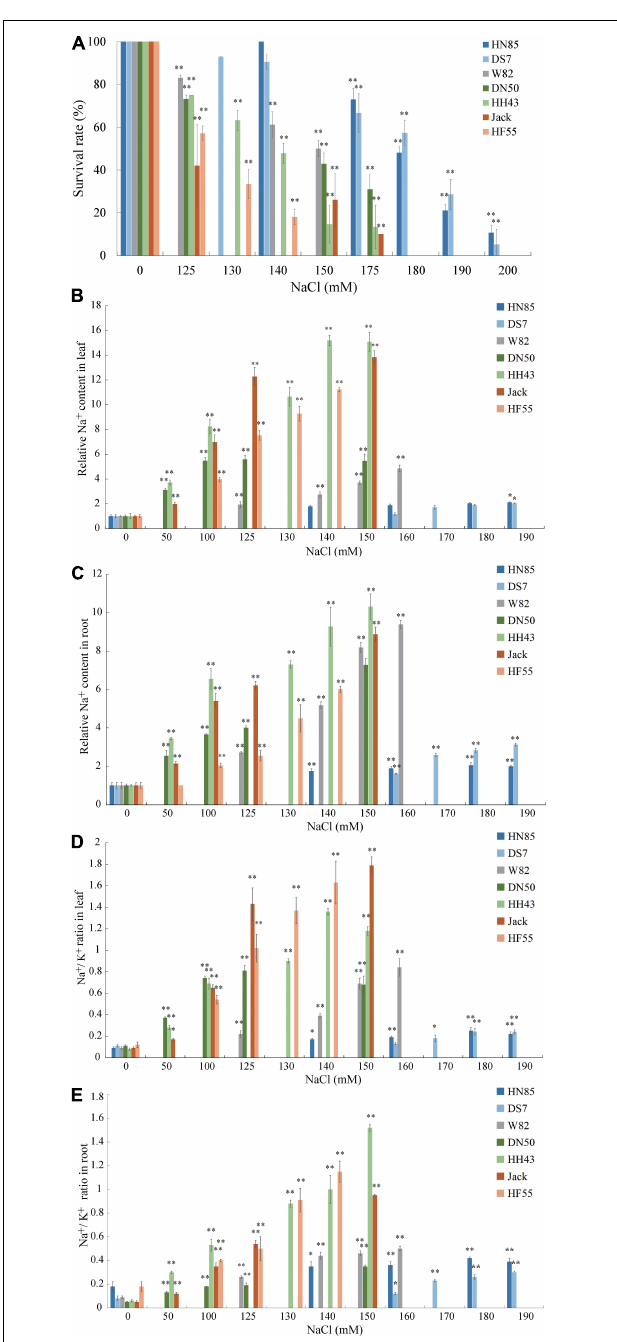
FIGURE 2 | Salt sensitivity assay of six soybean cultivars. (A) Survival rates of six soybean cultivars subjected to treatment with 0, 125, 130, 140, 150, 175, 180, 190, or 200 mM NaCl. The six soybean cultivars are Henong 85 (HN85), Dongsheng 7 (DS7), Dongnong 50 (DN50), Heihe 43 (HH43), Jack (Jack), and Hefeng 55 (HF55). (B) The Na + contents in unifoliate leaves of the six soybean cultivars. (C) The Na + contents in roots of the six soybean cultivars. (D) The change of Na + /K + ratios in unifoliate leaves of the six soybean cultivars. (E) The change of Na + /K + ratios in roots of the six soybean cultivars. Data are means ± SD [ n = 3 (there are at least 12 plants in each biological replicate)]. Significant differences in mean values relative to the mean value of unstressed plants are indicated by Student’s t -tests (* p < 0.05, ** p <